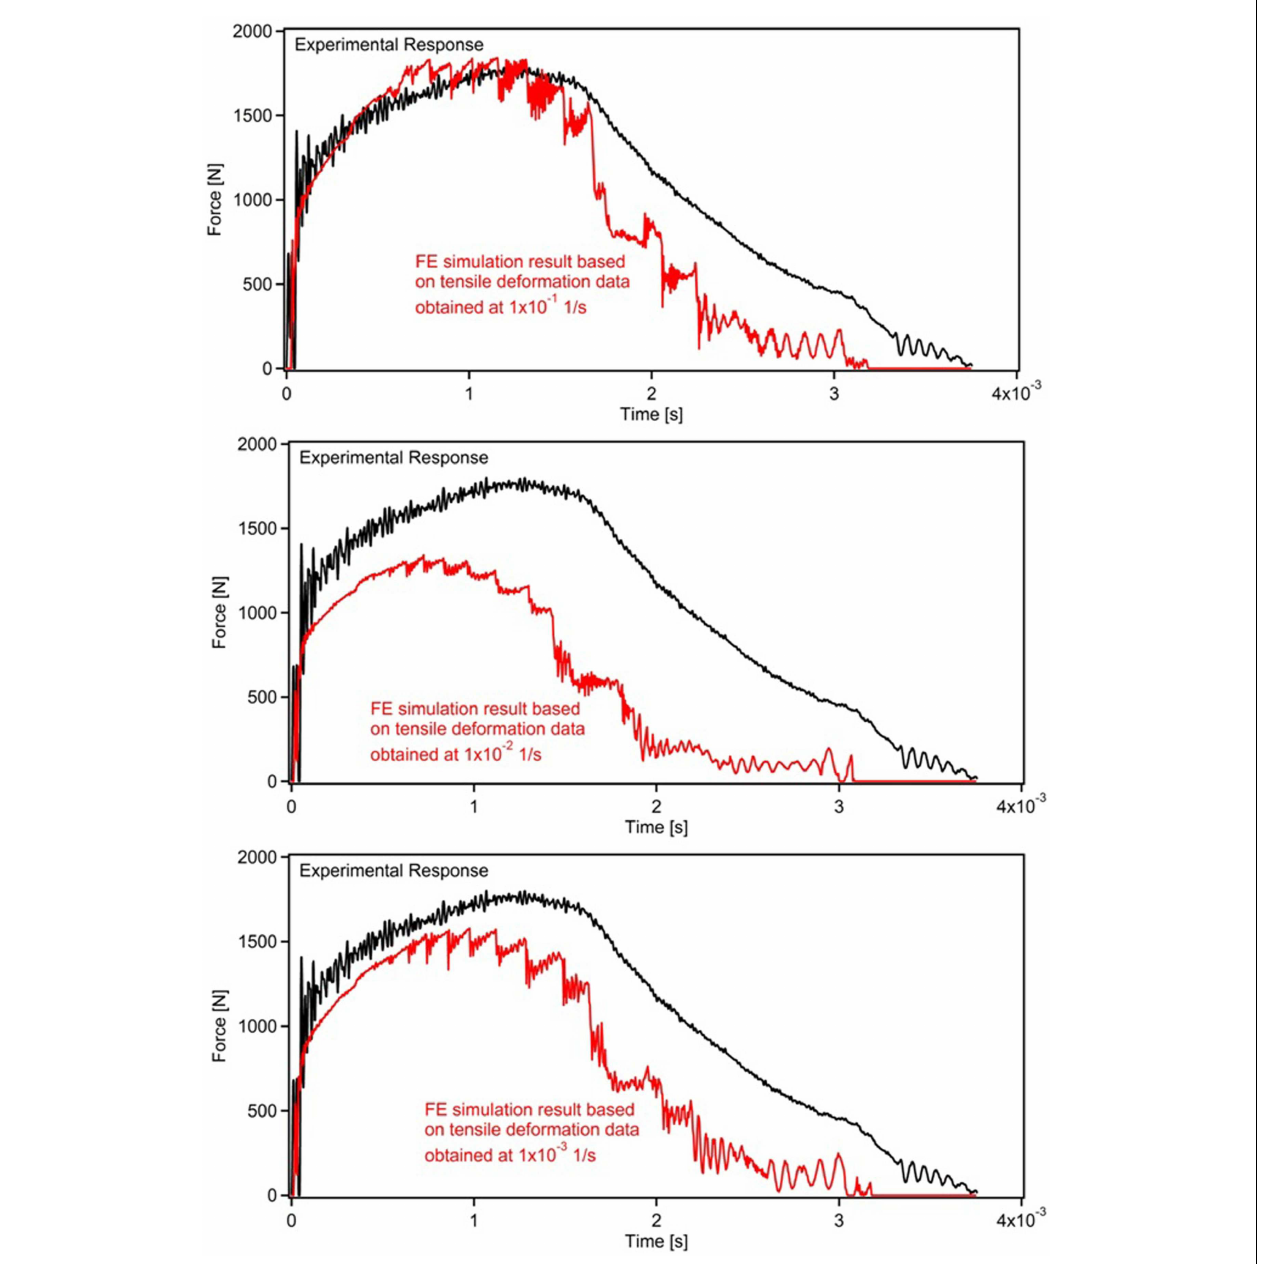
FIGURE 3 |A comparison of the RT experimental impact response of Hadfield steel and the corresponding FE simulation results, where the flow rule was defined based on the experimental uniaxial tensile deformation responses obtained at strain rates of 1 × 10 − 1 , 1 × 10 -2 , and 1 × 10 − 3 1/s